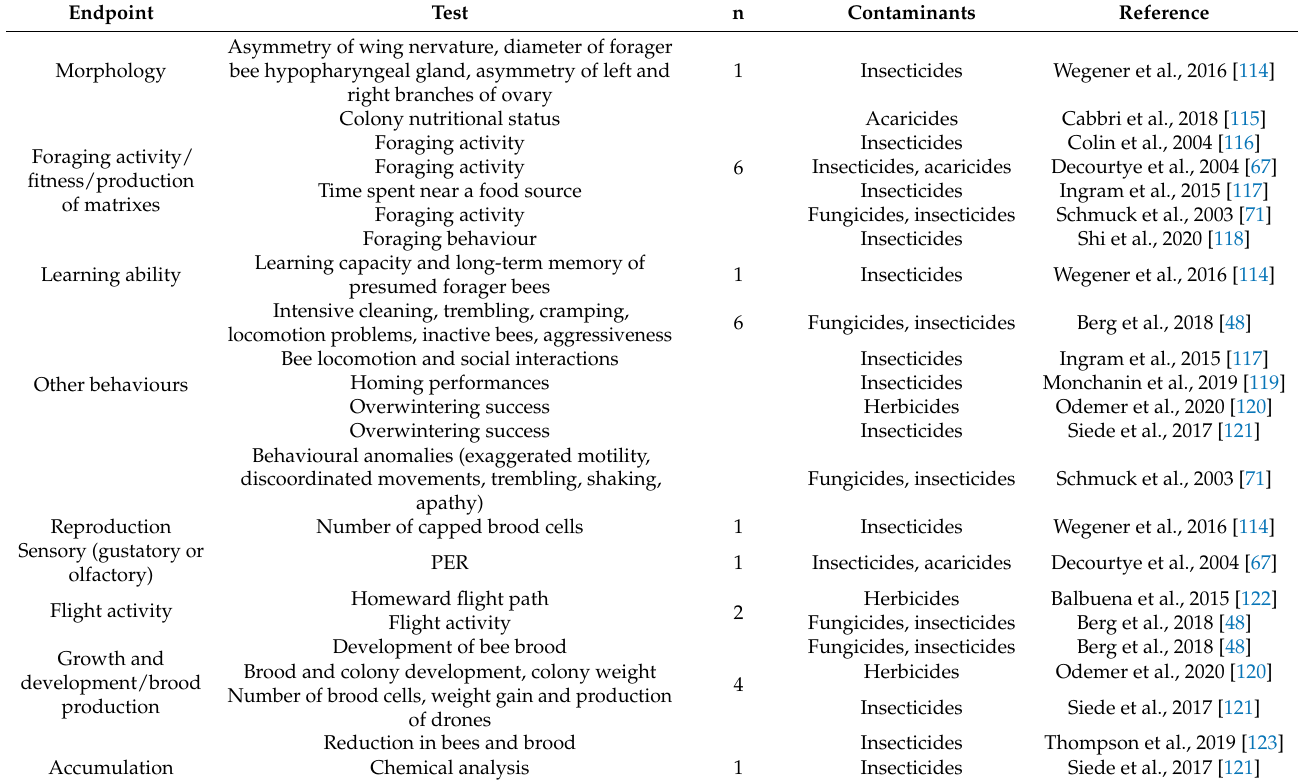
Table 3. Summary of semi-field studies divided by endpoint and